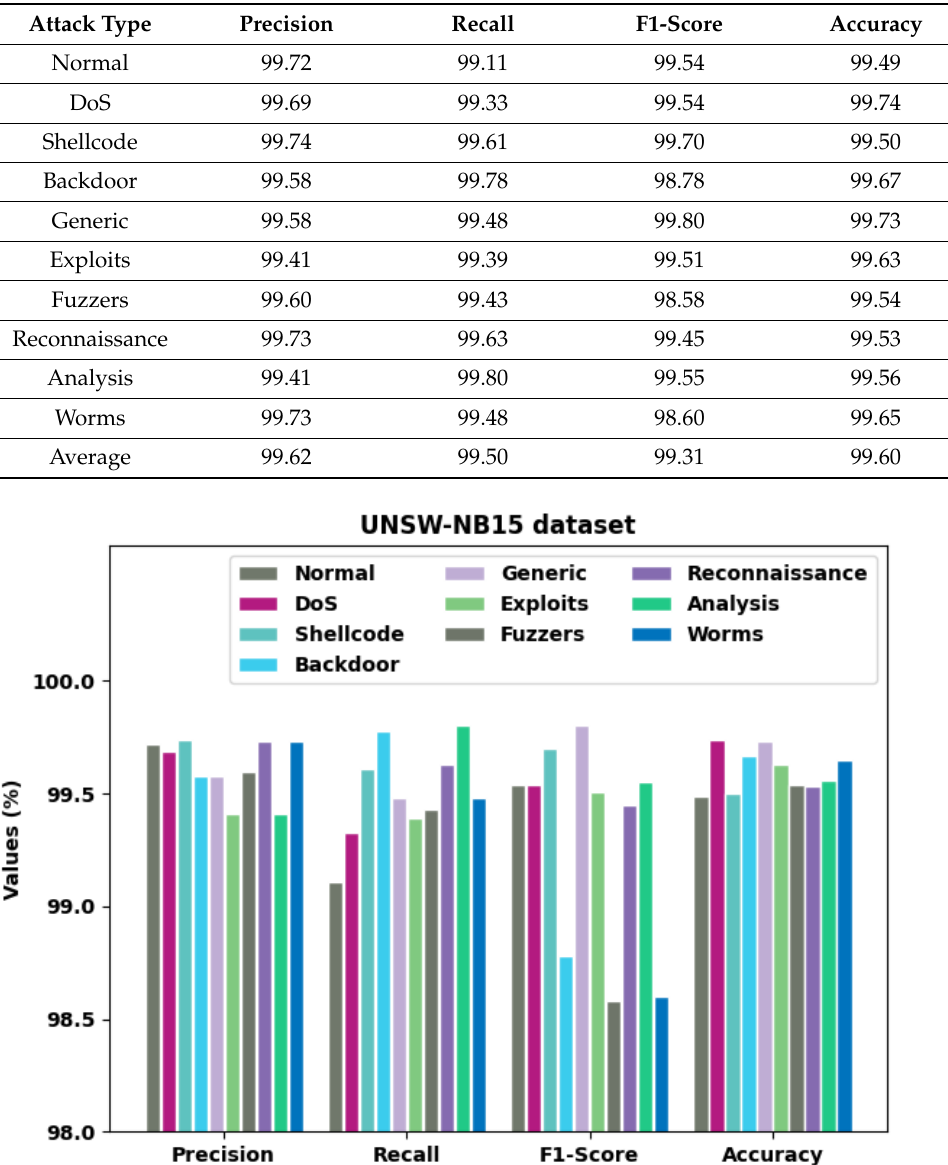
Figure 6. Result analysis of OMLIDS-PBIoT technique under UNSW-NB15 dataset.